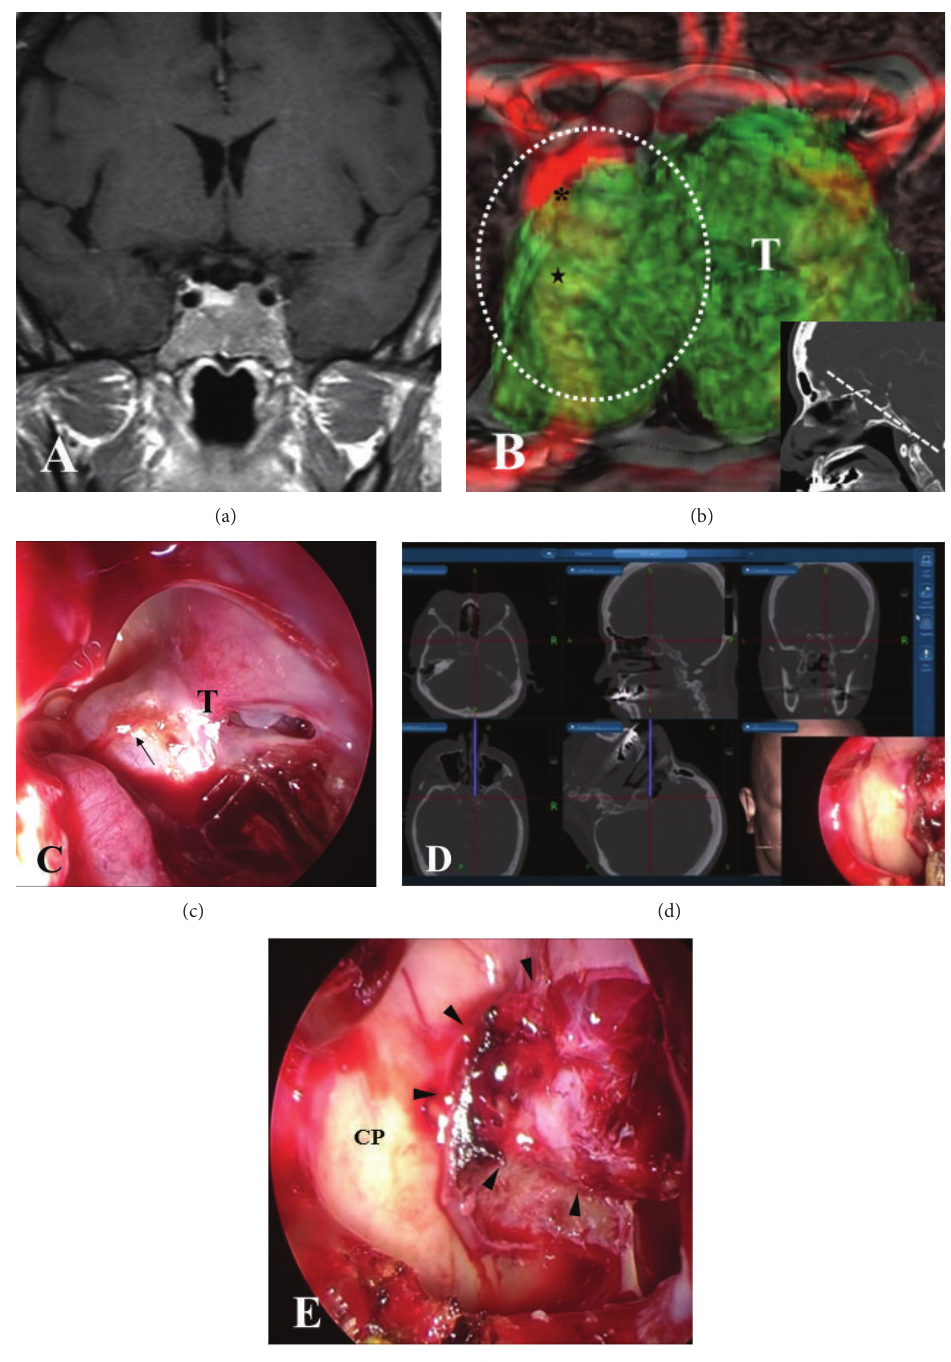
Figure 2: Preoperative image of a fusion model of 3D-CT and MRI and intraoperative endoscopic view in Case 1 . (a) Preoperative coronal Gd-enhanced MRI in Case 1 showing a pituitary tumor with extensive invasion into the sphenoidal sinus. (b) Preoperative 3D-CT and MRI fusion model demonstrating that bilateral ICAs (C3 and C4 portions) are buried in the invasive tumor at the anterior plane of the sella (inset) (stars: C4; asterisks: C3). (c) Endoscopic view before tumor resection showing the massive tumor that widely protruded into the sphenoidal sinus. (d) A neuronavigation system demonstrating the locations of the ICAs and the destroyed sella in the endoscopic view (c). CT images on the navigation display show the position of the chip and trajectory of the flexible probe that was placed on the marked position (black arrow) on the endoscopic view (c). (e) Endoscopic view after resection of the tumor showing the widely eroded sellar floor occupied with residual intrasellar tumor and intact bony structures over the ICAs (arrowheads: eroded sellar floor; CP: ICA prominence). T: tumor; the area of white-dashed line: endoscopic view in